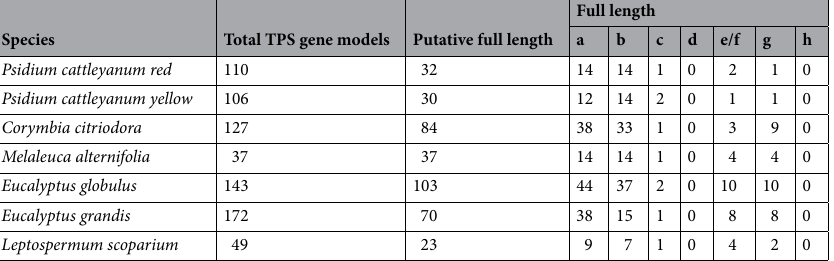
Table 2. Numbers of TPS genes in Myrtaceae